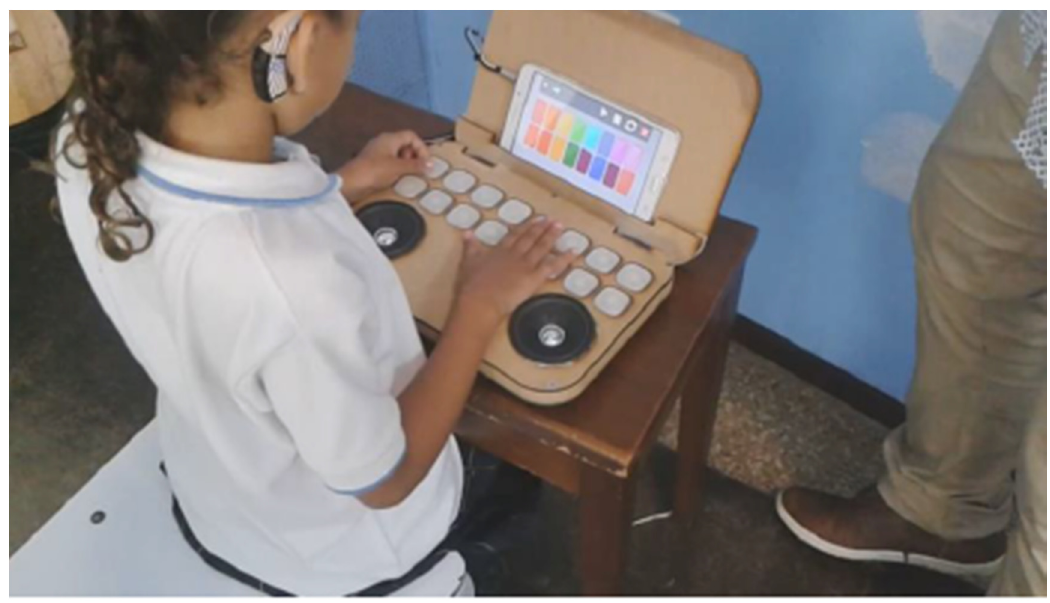
Figure 11. Design of CASETO for the Institute of Blind and Deaf Children of Valle del Cauca, Colombia.